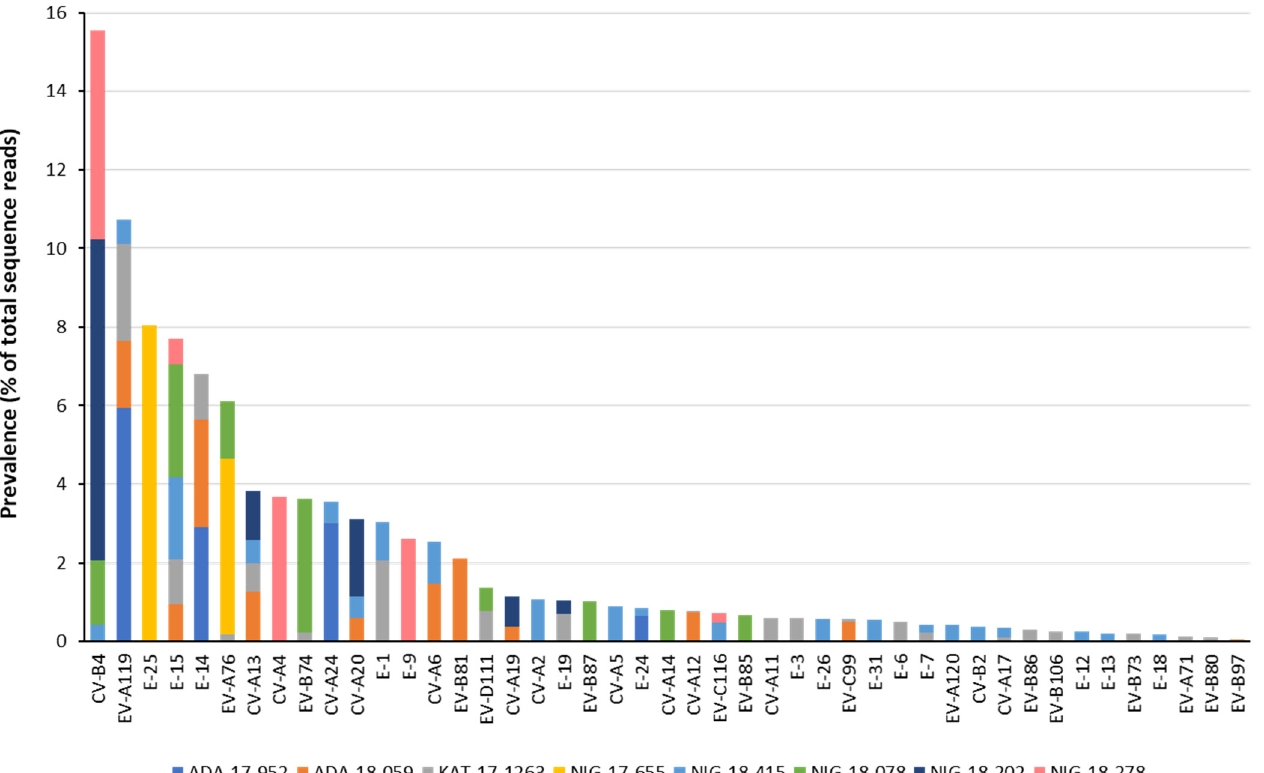
Figure 2. Overall prevalence of EV serotypes in water samples from Nigeria. Filtered NGS reads from RT-PCR products from the water concentrates were mapped to consensus sequences obtained for each sample. The proportions of NGS reads mapping to each EV serotype are shown. The sample source is shown in different colors as indicated at the bottom of the figure.